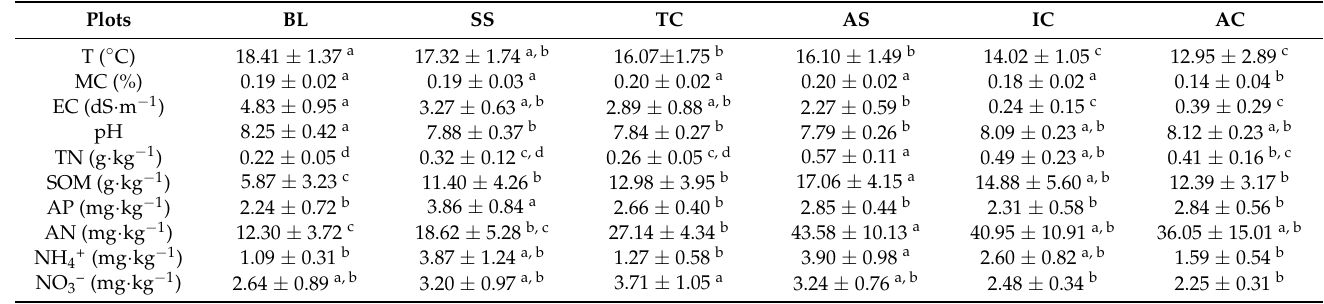
Table 1. Physicochemical soil analysis of each plot in the Yellow River Delta.